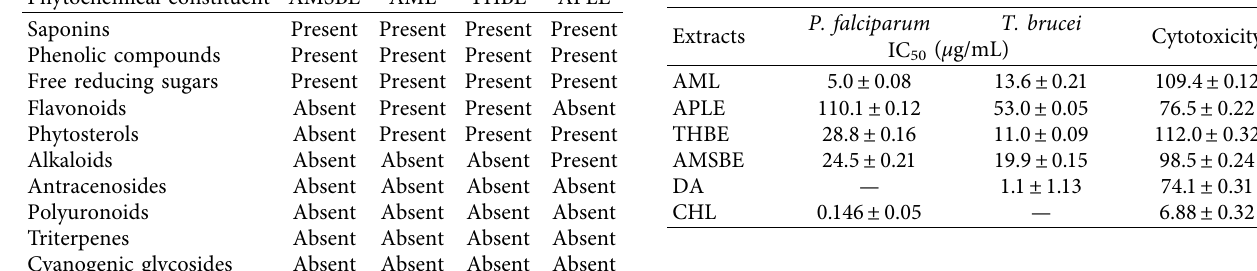
Table 2: Phytochemical screening results of the extracts. Table 3: IC